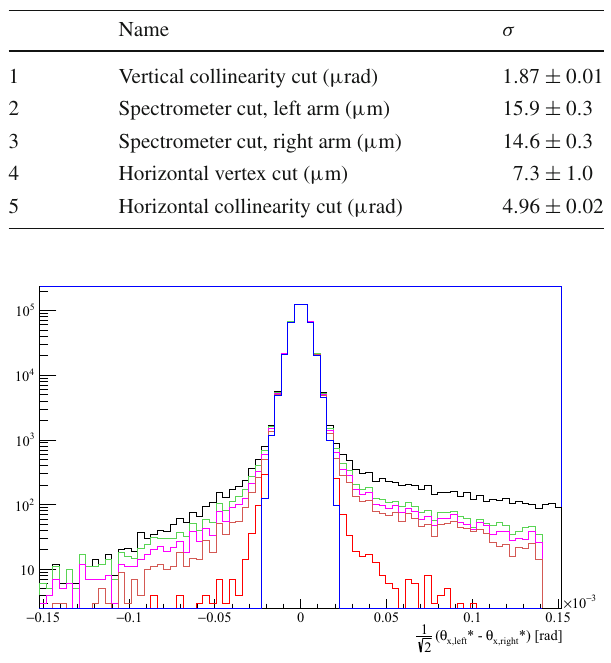
Fig. 3 The horizontal beam divergence estimated from the data of Diagonal 1 by comparing the reconstructed horizontal scattering angle θ ∗ x of the left and right arm. The distribution is shown before any analy- sis cut (black solid line) and after each analysis cut following the order in Table 1